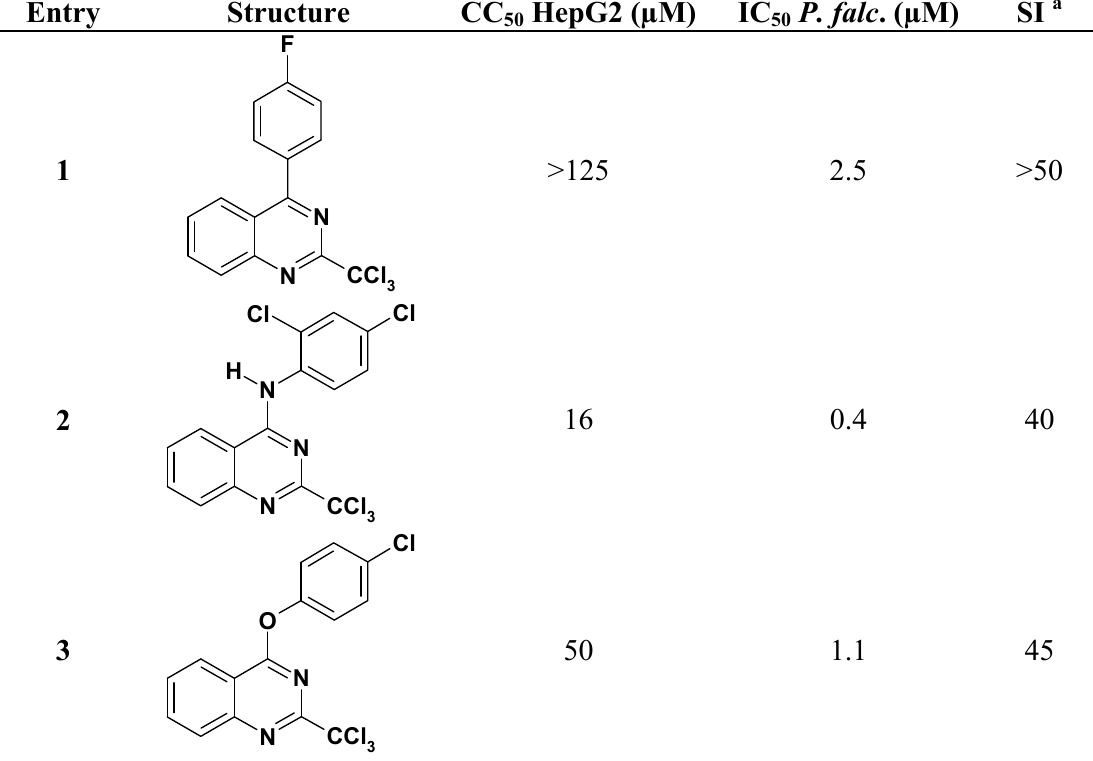
Table 2. Antiplasmodial and cytotoxicity evaluation in 2-trichloromethylquinazoline series.